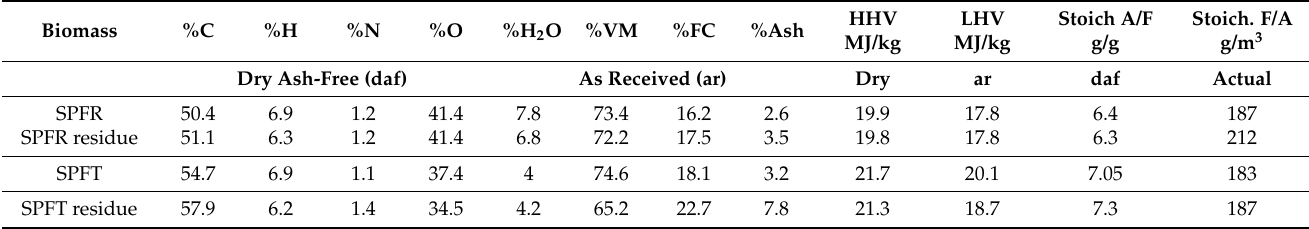
Table 1. Proximate and ultimate analysis of the samples.